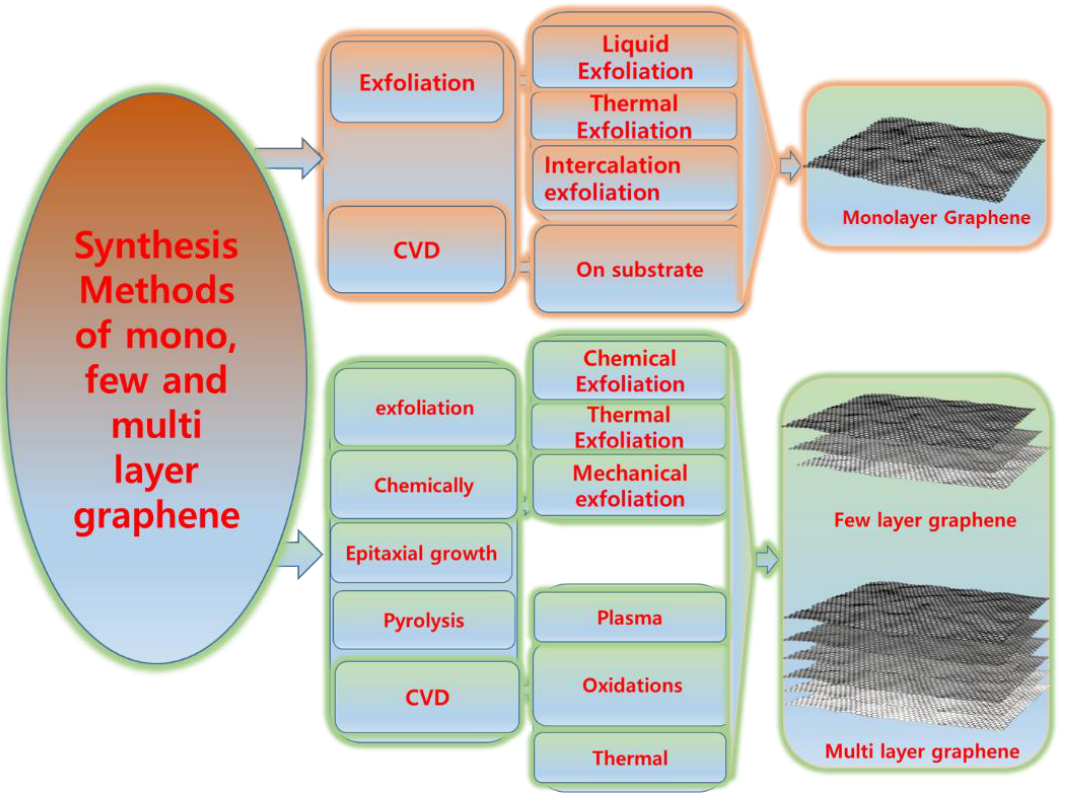
Figure 2. Schematic overview of the process for obtaining different layers of graphene.